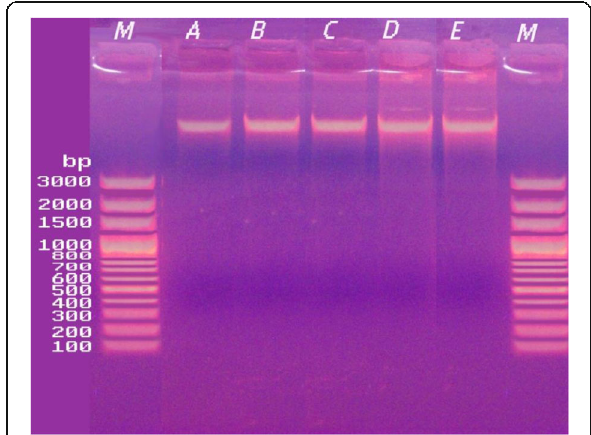
Fig. 2 Gel electrophoresis photograph showing the genomic DNA of the brain of mice administered with 5 and 10 mg/kg bw cisplatin. Lane A, control. Lanes B and C, 5 mg/kg bw cisplatin. Lanes D and E, 10 mg/kg bw cisplatin. Lane M, DNA